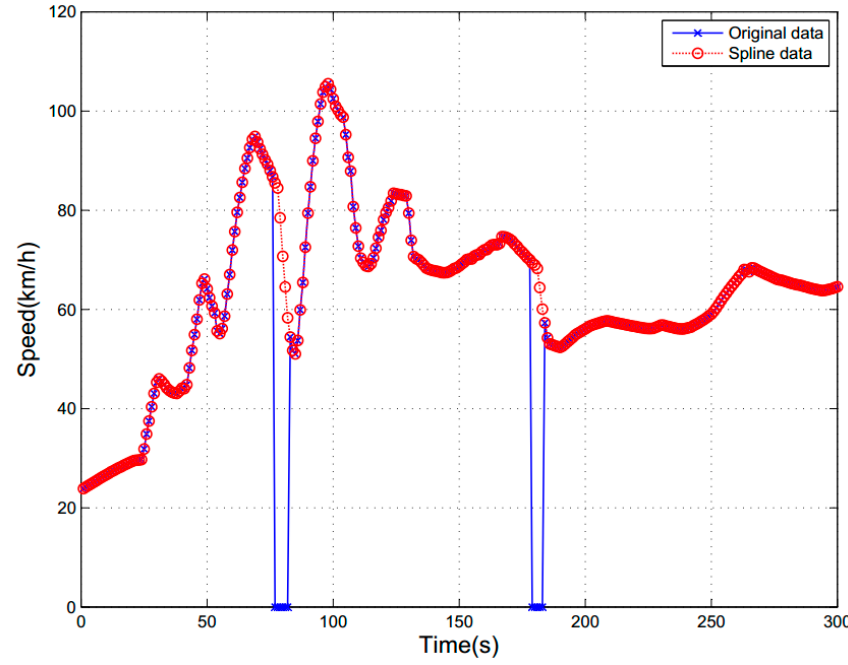
Figure 6. A sample of cubic spline interpolation.